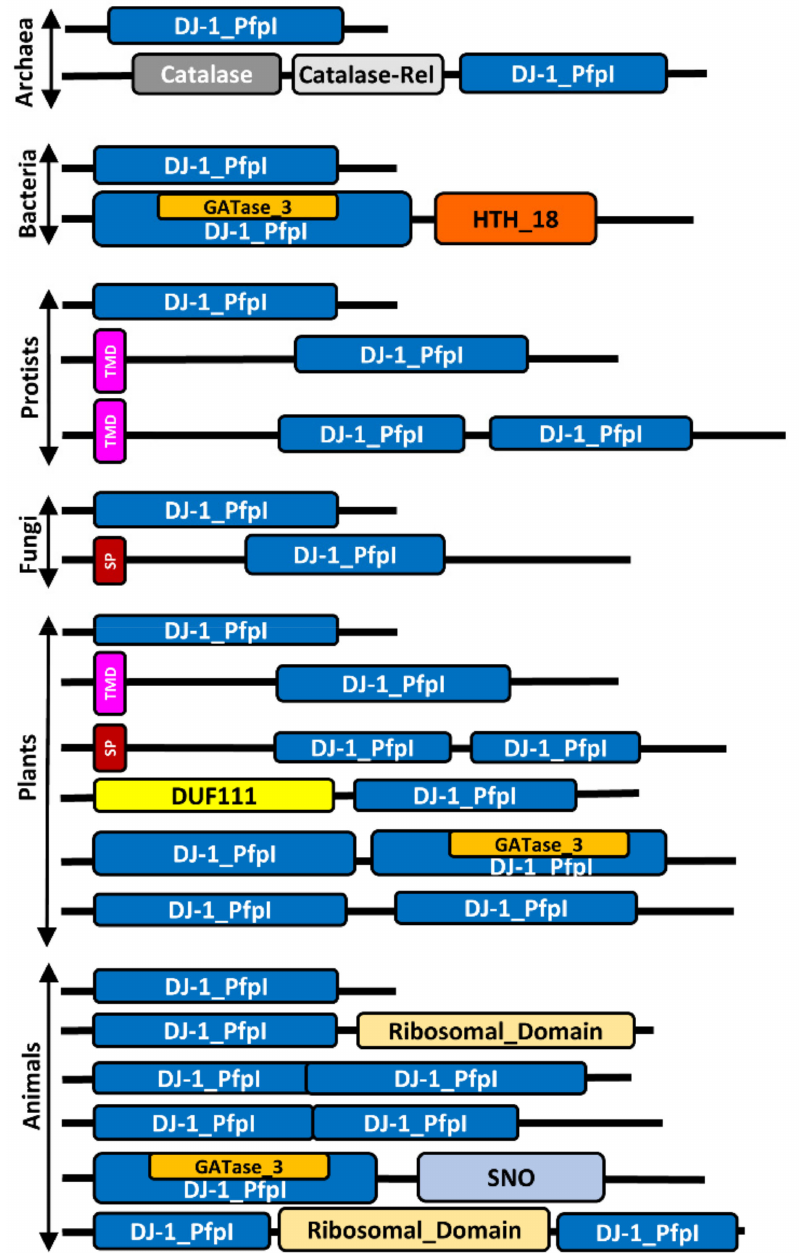
Figure 2. Schematic depiction of domain architecture observed in GLYIII proteins from different kingdoms. GLYIII proteins essentially contain DJ-1_PfpI domains often in combination with other domains such as catalase, HTH_18 (helix-turn-helix), DUF (Domain of unknown function), SNO (glutamine amidotransferase), etc. Two DJ-1_PfpI domains are common to plant GLYIII and some instance of its presence is also seen in animals. Image shown is not to scale. TMD—transmembrane domain, SP—signal